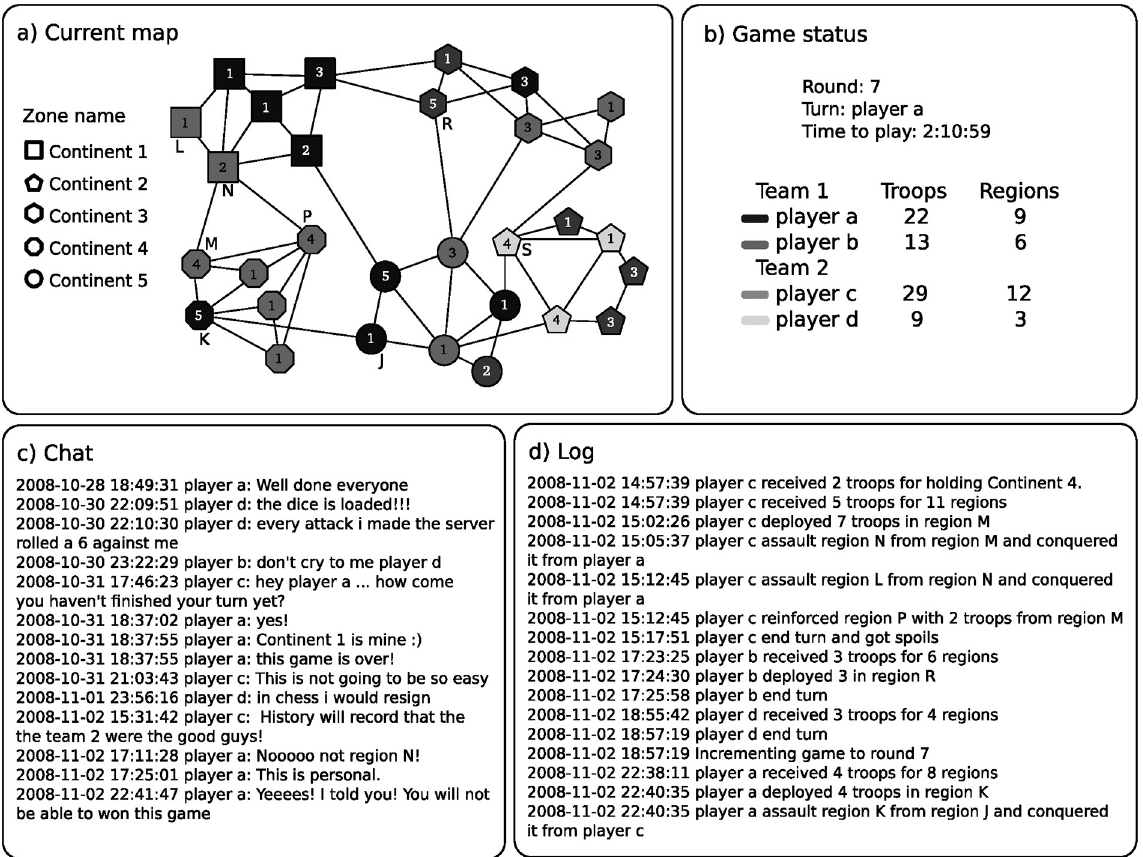
Fig 5. Scheme of Conquer Club game. a) The current game board showed as a graph with continents (regions of the same shape), players (regions of the same grayscale), and a number of troops in each region. The capital characters represent the names of the closest region. b) General game status: current round, the active player, and remaining time to play; and a summary of total troops and controlled regions for each player. c) Example of chat session during a game. d) Log of game used to extract game information with a scrapper.